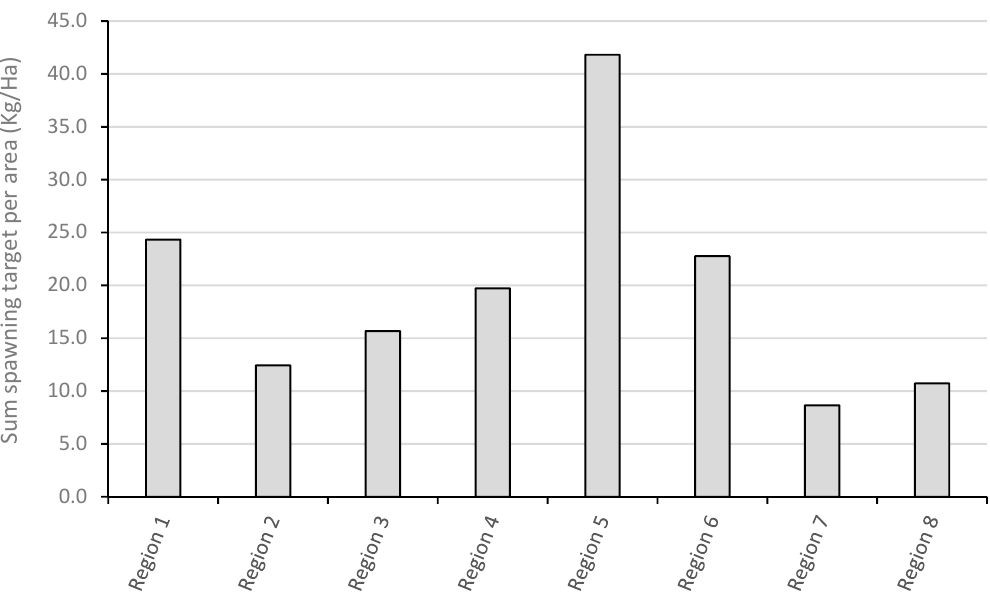
Figure 2. Spawning target (ST) (modelled conservation limit) summed for all rivers in each of eight studied regions. The ST is corrected for total river smolt production area.